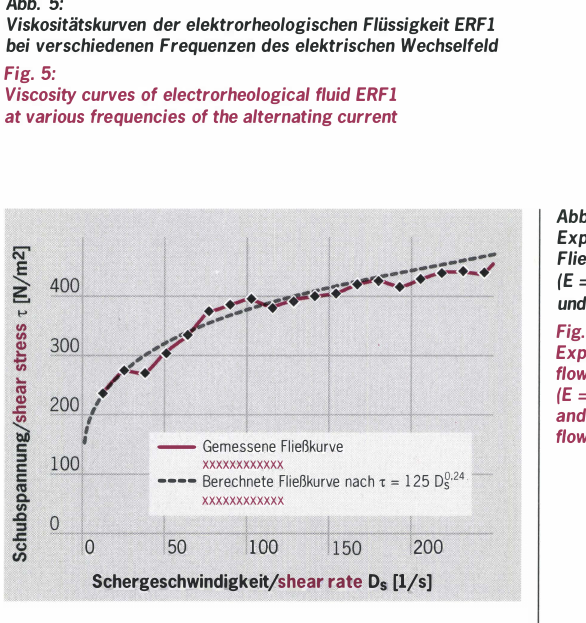
Fig. 5: Viscosity curves of electrorheological fluid ERFl at various frequencies of the alternating current